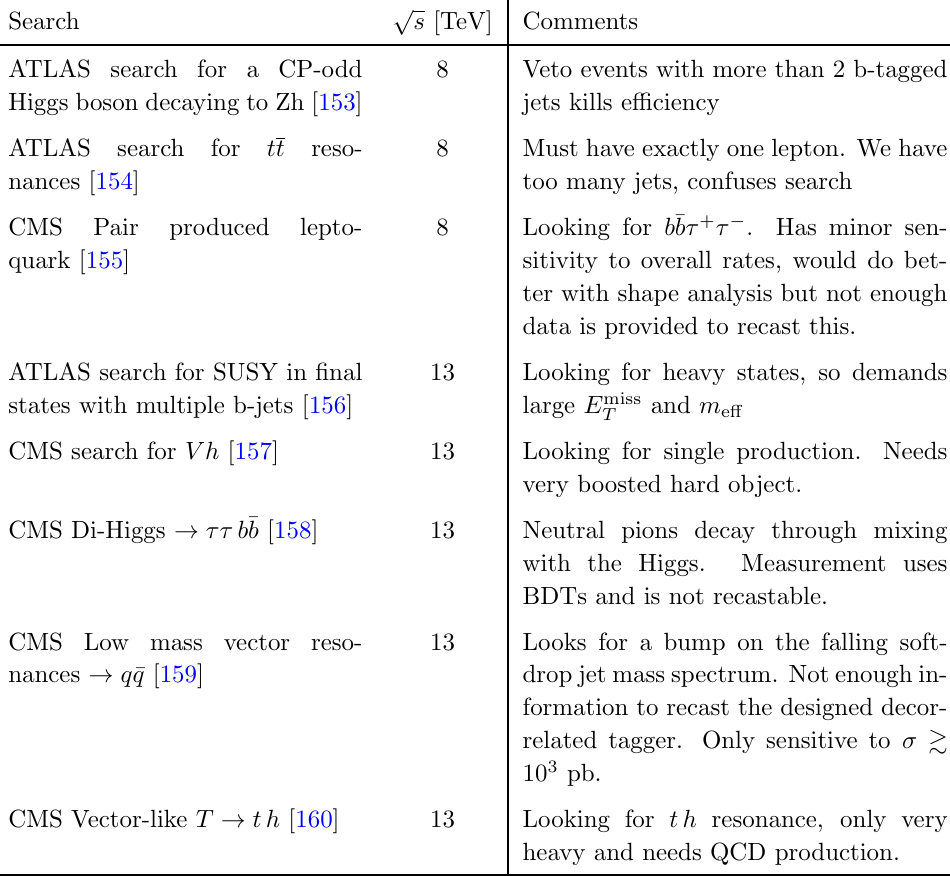
Table 3 . Possible search strategies which seem like they should set bounds, but have limited-to-no